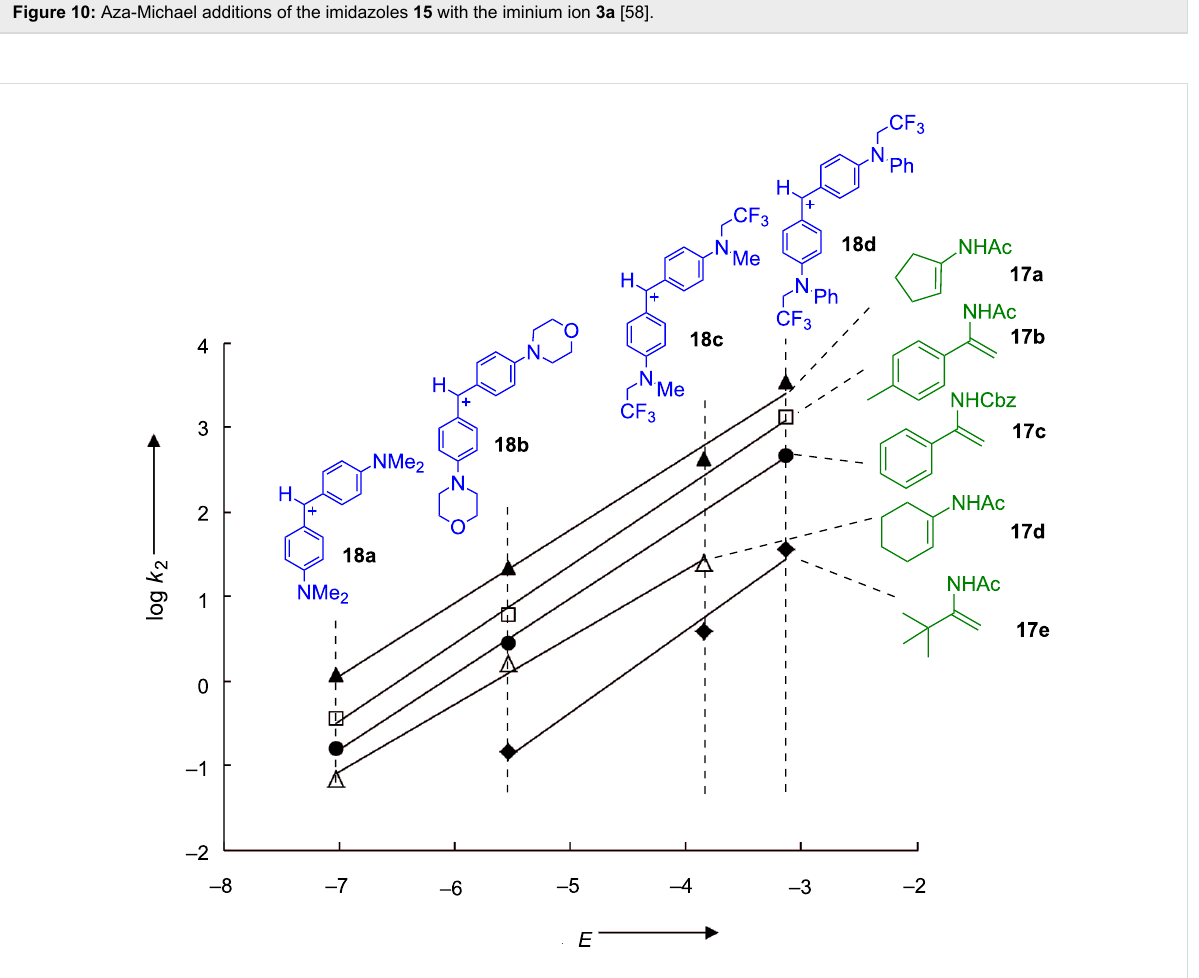
Figure 11: Plots of log k 2 for the reactions of enamides 17a – 17e with the benzhydrylium ions 18a–d in CH 3 CN at 20 °C versus the electrophilicity parameters ( E